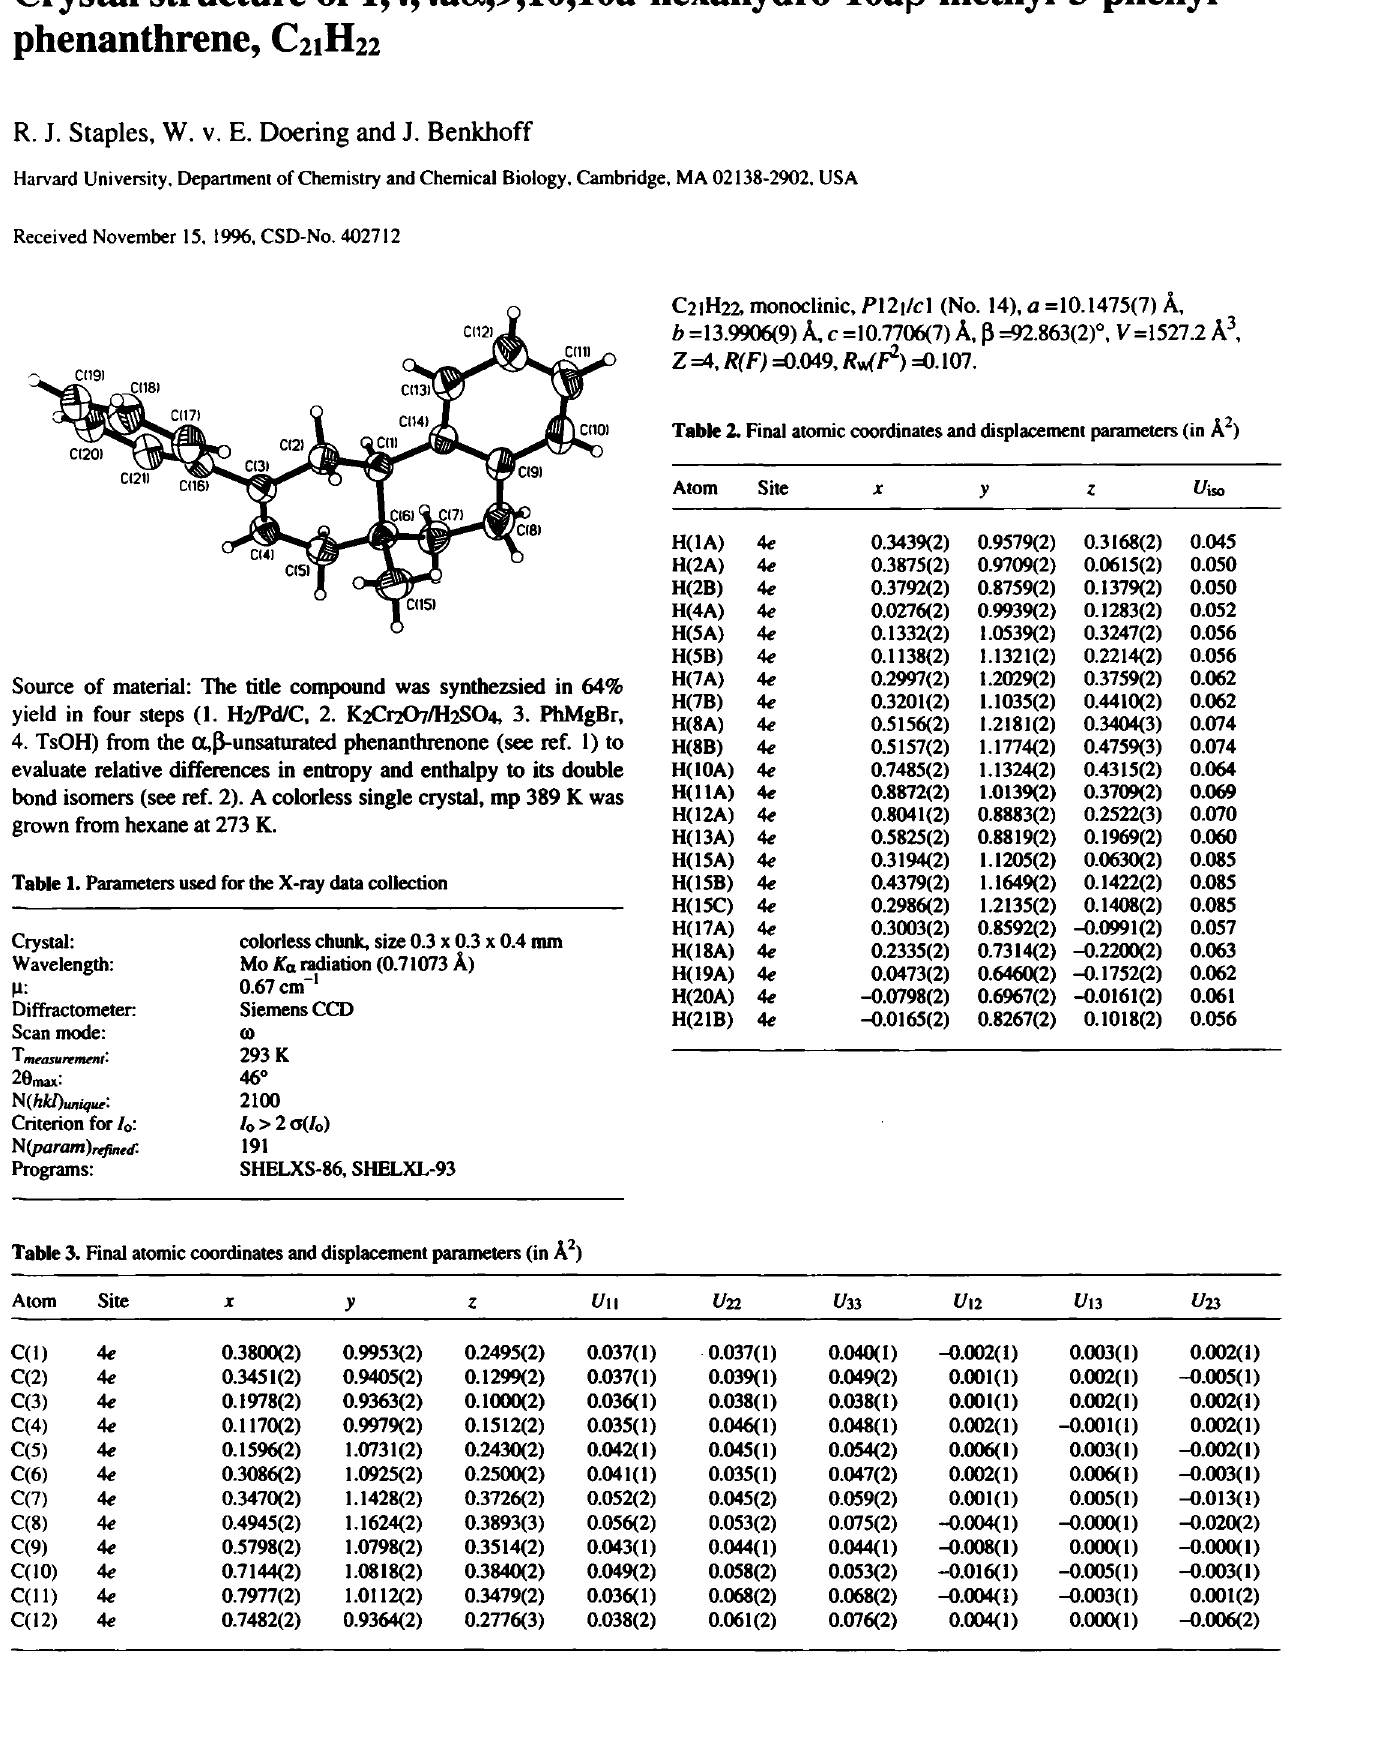
Table 3. Final atomic coordinates and displacement parameters (in Â 2 )